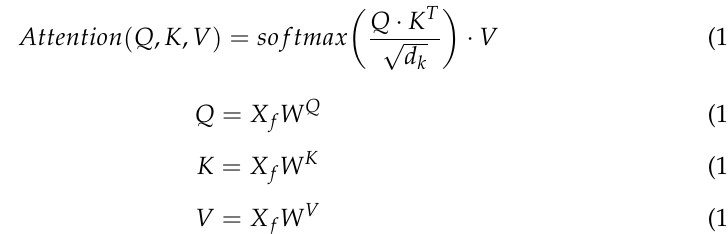
Figure 5. The architecture of the transformer encoder module. ( a ) the architecture of the trans- former encoder module, ( b ) the internal architecture of the MLP.